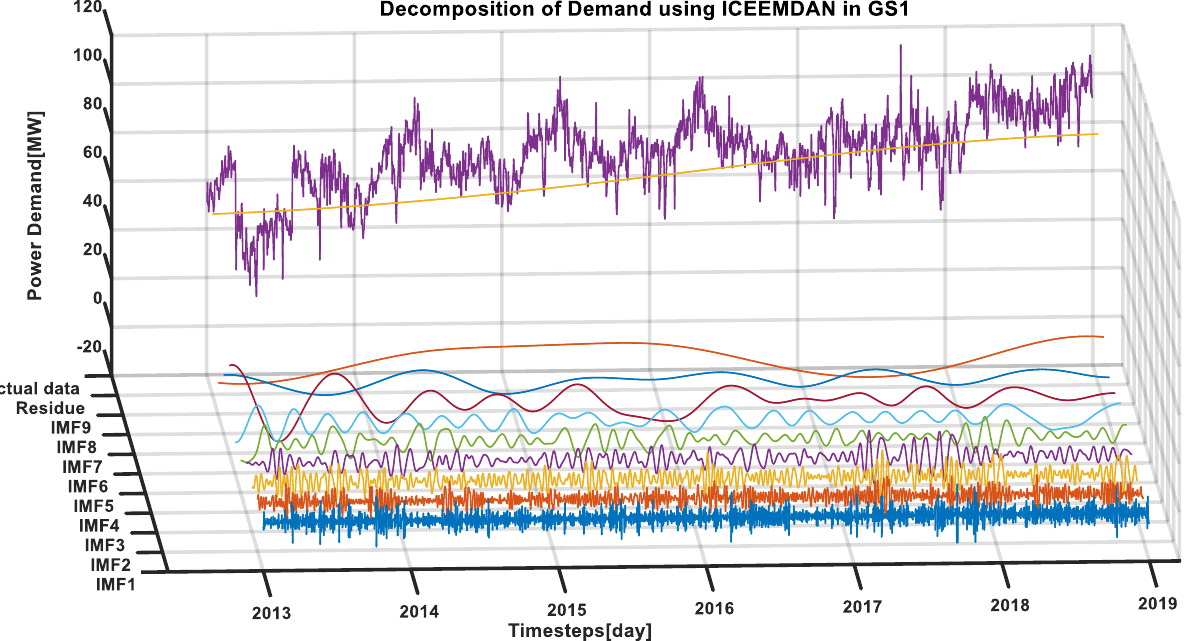
Figure 7. Decomposition results of the daily power demand using the ICEEMDAN method at the GS1 site with nine IMFs and the residue. The dark blue color, brown color, dark yellow color, dull violet color, green color, deep blue color, red color, navy color, tawny brown color, gold color, and purple color represent the characteristic of IMF1, IMF2, IMF3, IMF4, IMF5, IMF6, IMF7, IMF8, IMF9, residue, and actual data (daily power demand), respectively.